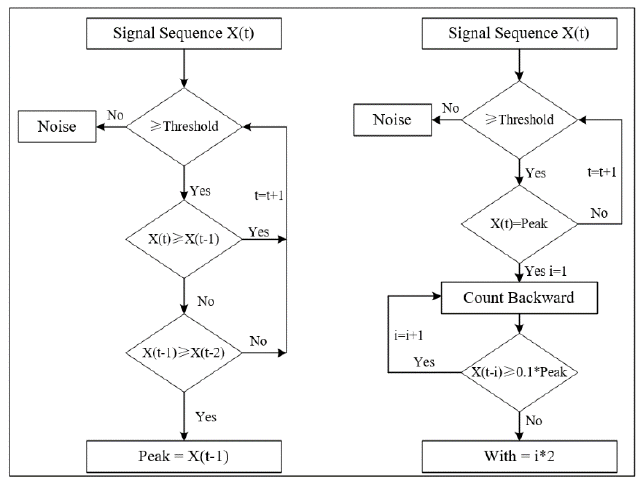
Figure 5. Debris identification method.